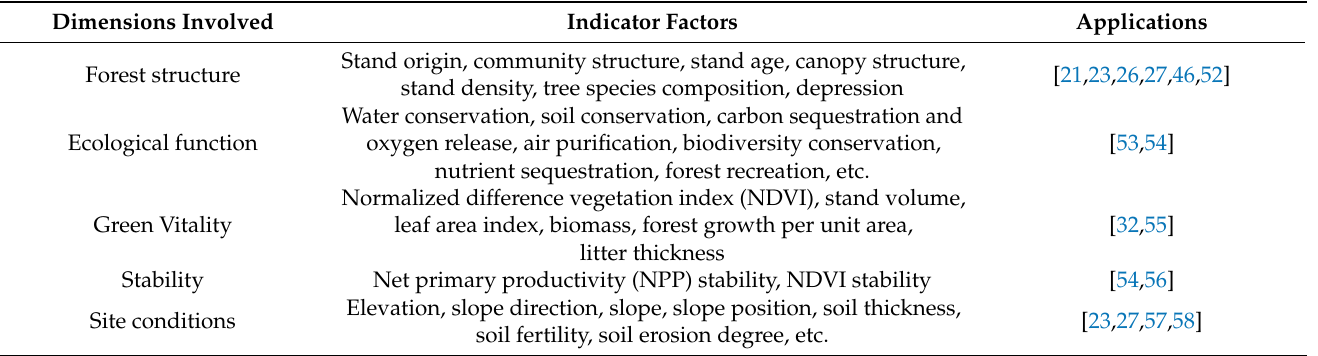
Table 1. Forest ecosystem quality assessment